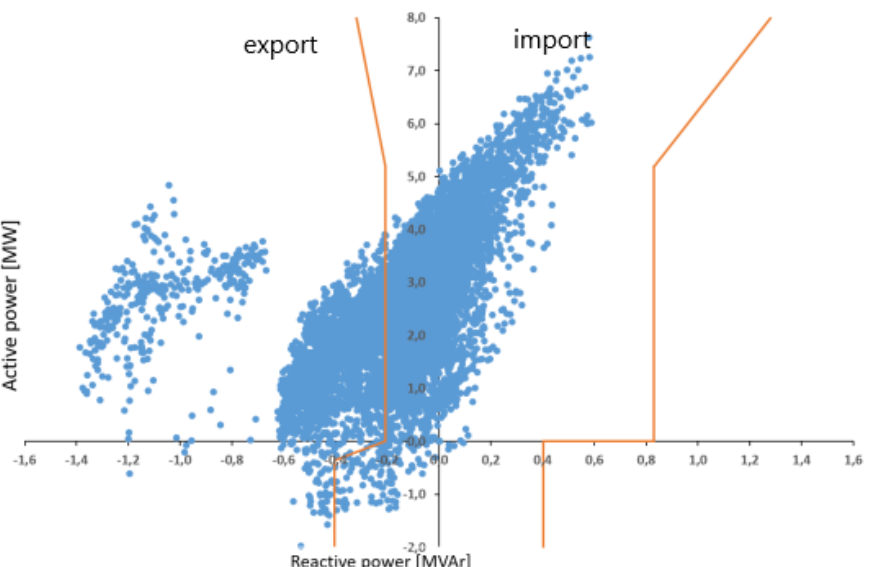
Figure 6. Measured reactive power exchange between Sundom and the transmission system with respect to the limits set by the TSO. The positive sign indicates power flow from the transmission to the distribution system.